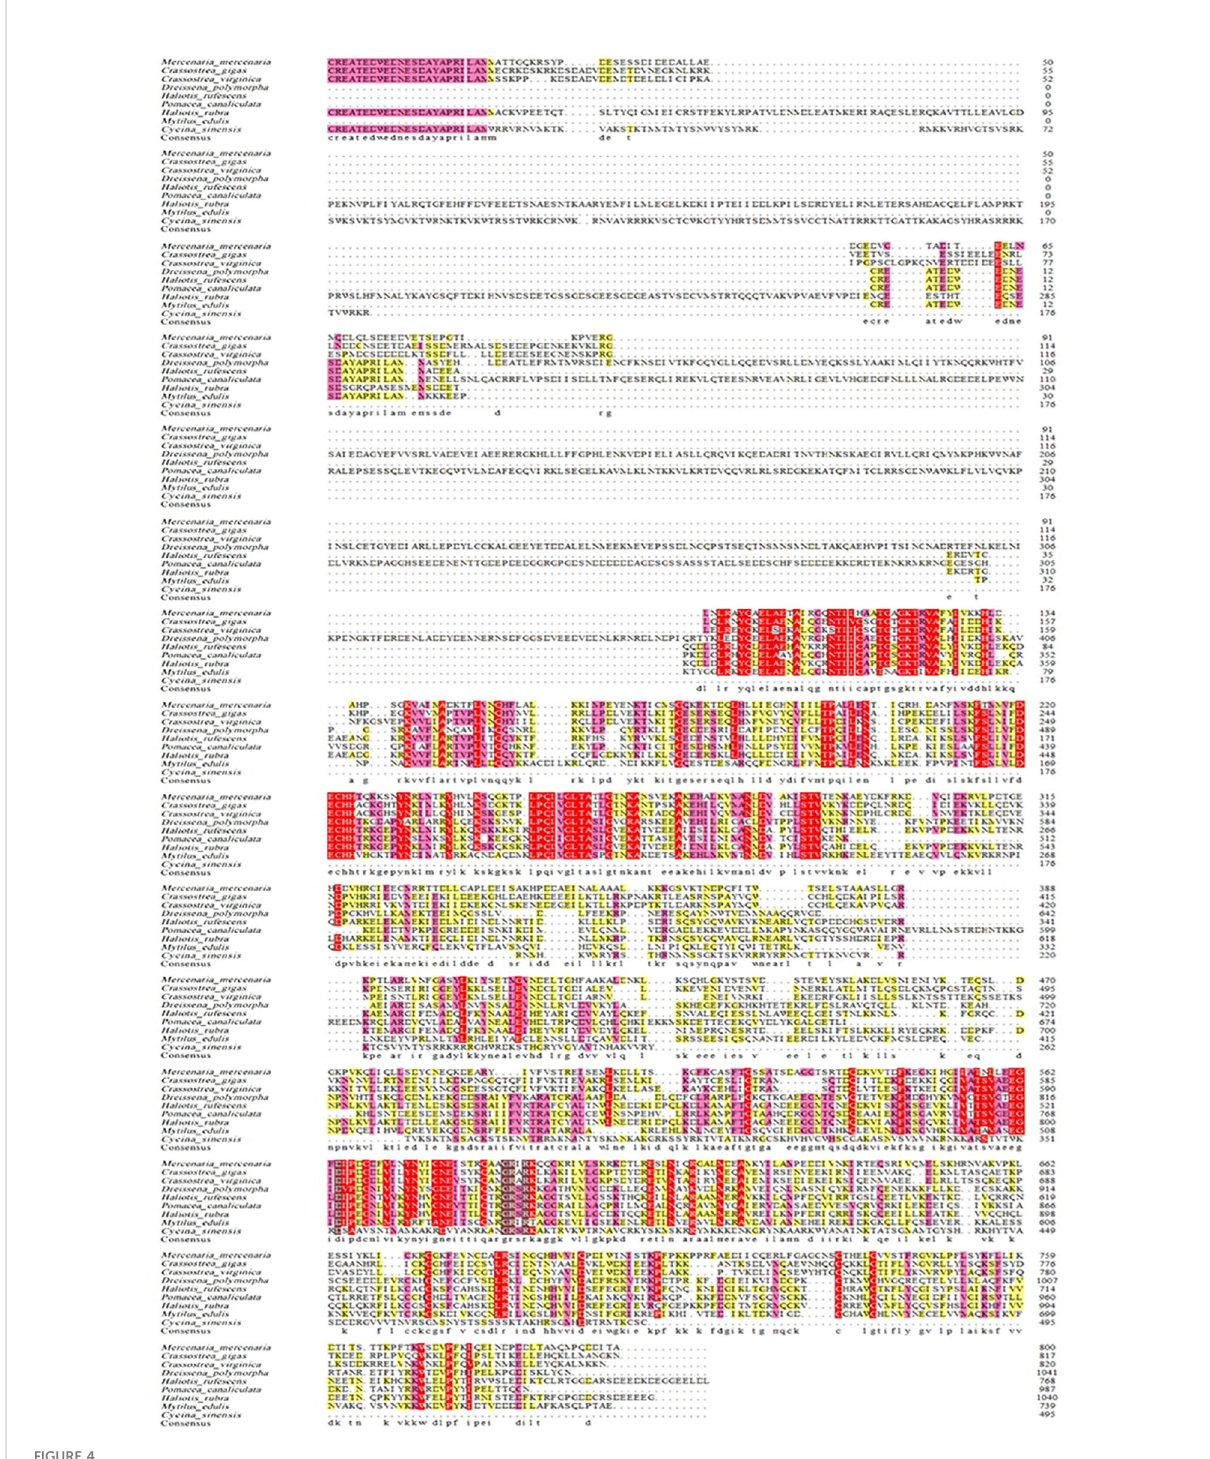
FIGURE 4 Alignment of the IFITM1 amino acids from Cyclina sinensis and other species. All shaded regions represent residues sharing homology. The light red regions represent homology above 75%, while the dark red regions represent 100% homology. Dots denote amino acid